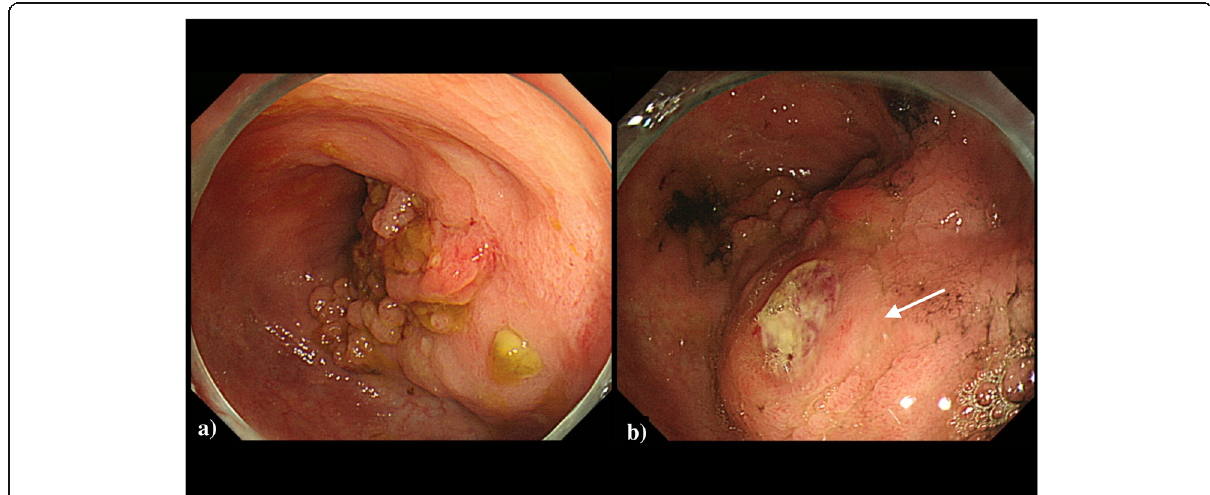
Fig. 2 a Preoperative colonoscopy showed a group of a lateral spreading tumor of granular type of descending colon. b Second colonoscopic examination revealed the biopsy site of tumor (white arrow) was abnormally